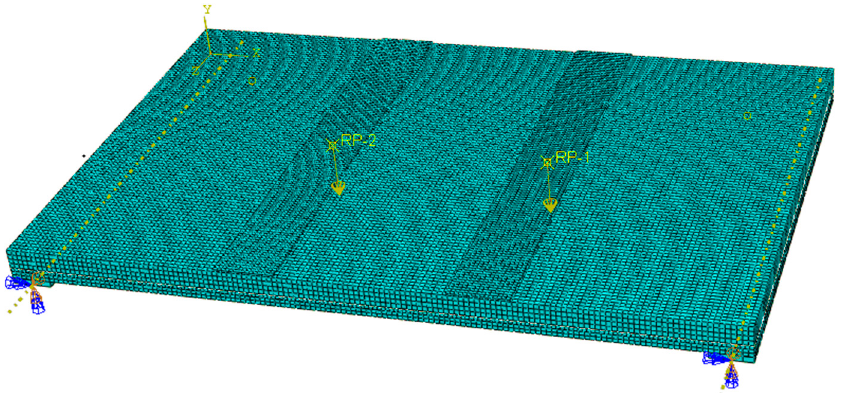
Figure 17. Finite element model of the specimen.